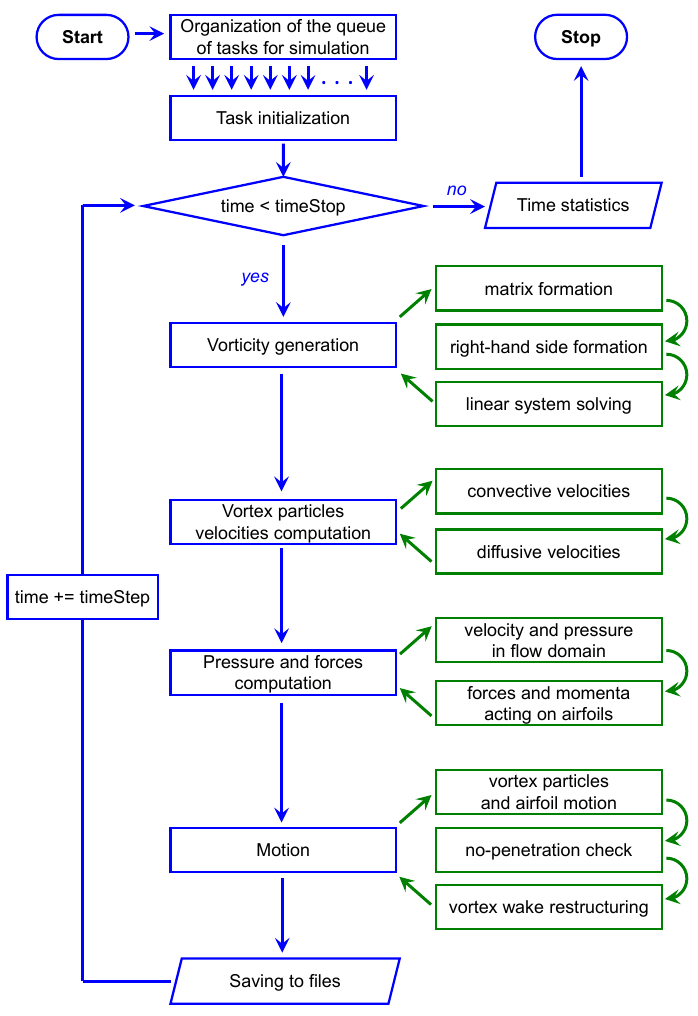
Figure 12. Flowchart of the